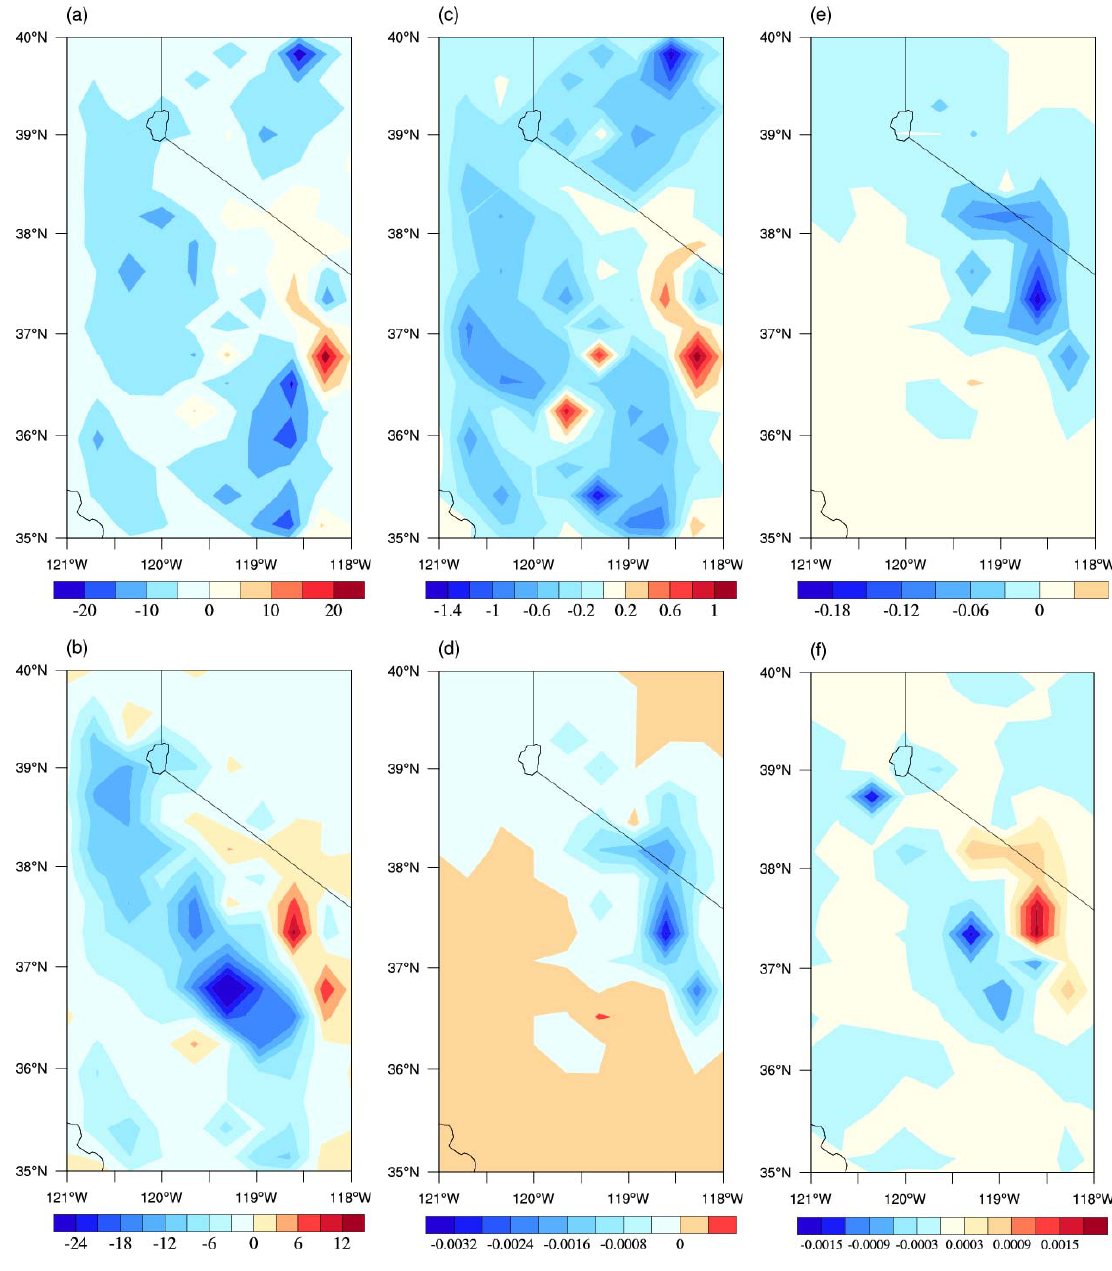
Fig. 4. Differences in the (a) sensible heat flux (Wm − 2 ), (b) latent heat flux (Wm − 2 ), (c) surface skin temperature (K), (d) surface albedo, (e) snow water equivalent (kgm − 2 ), and (f) soil moisture (m 3 m − 3 ) between experiments RAD 3-D and CTRL at 9a.m. on 29 March 2007.